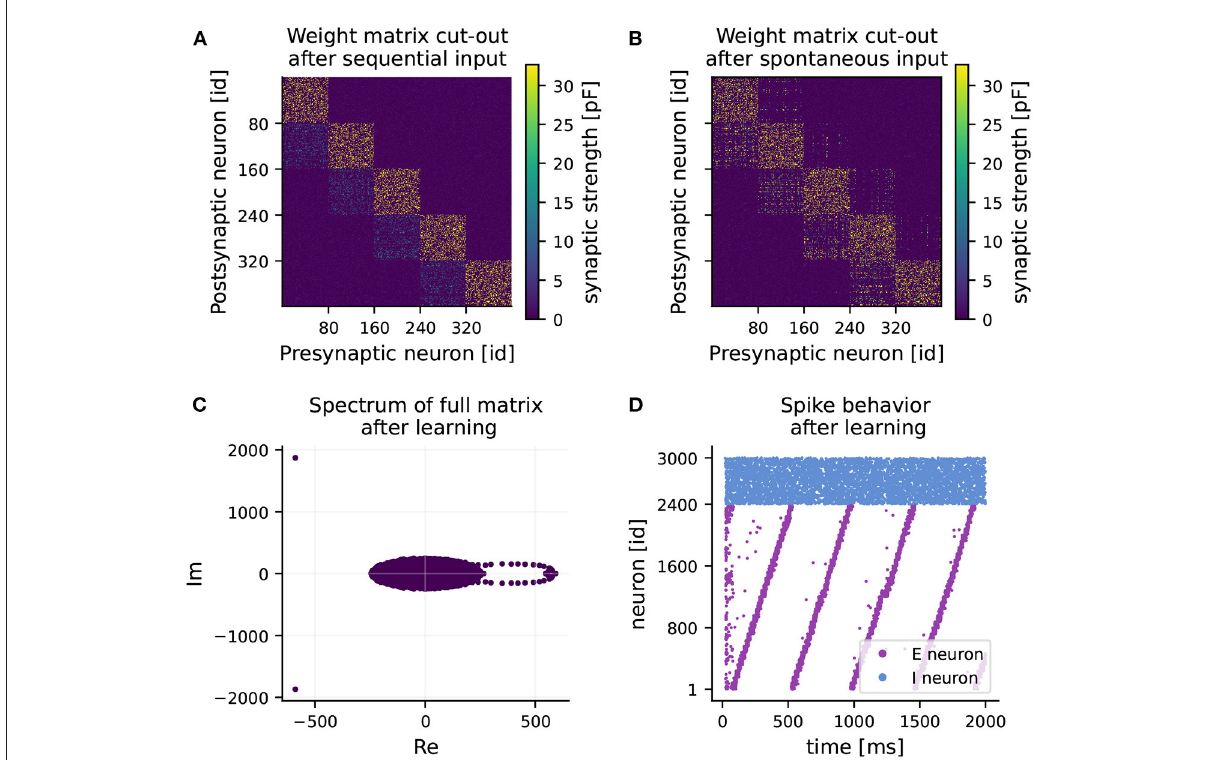
FIGURE2 RNN learns feedforward structure and develops sequential dynamics. (A) Weight matrix of connections from excitatory to excitatory neurons (EE) after 1 hour of training (sequential input only). Note, only a 400 × 400 sub-matrix including five clusters is shown. (B) Final weight matrix of EE connections after 2 hours of training (sequential input followed by spontaneous input). (C) Final spectrum of the full weight matrix. The majority of the eigenvalues are distributed in a circle around the origin (appearing as an ellipse due to different scaling of the axes). (D) Spiking activity of excitatory (purple) and inhibitory (blue) neurons over time after training under spontaneous external input, while keeping the learned weight matrix